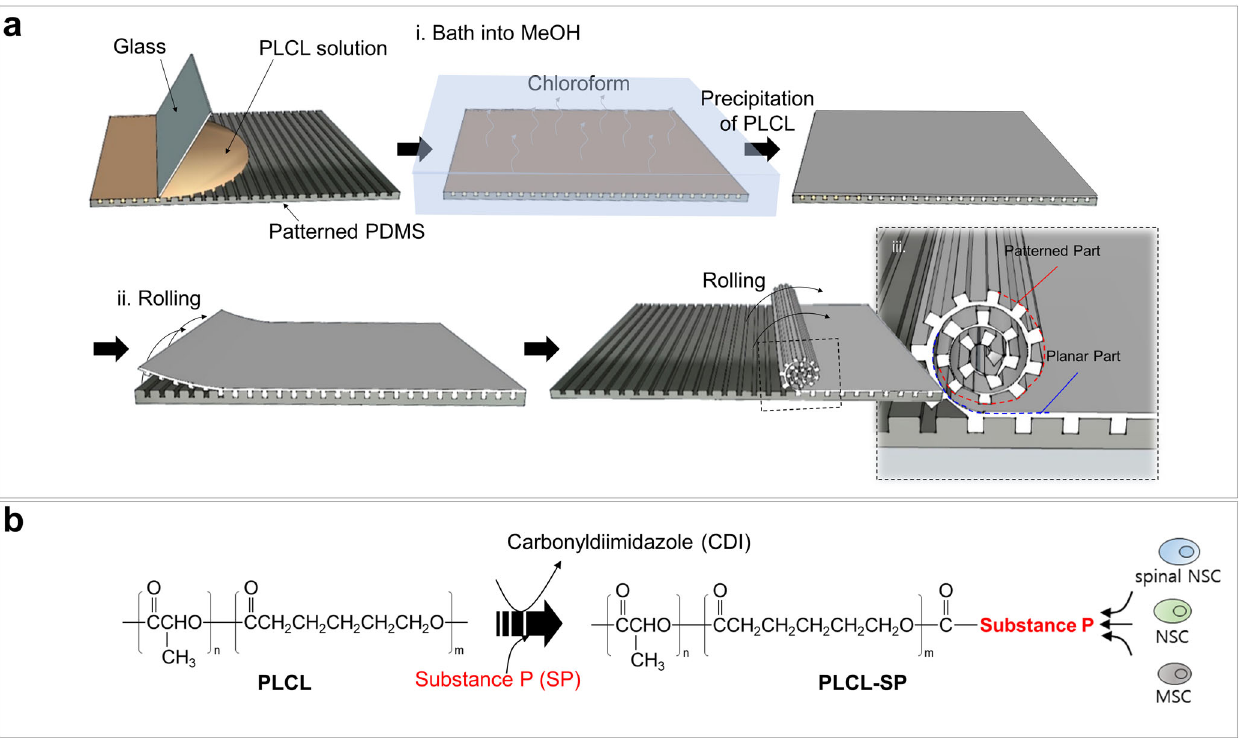
Fig. 1 Production of a multichannel NGC displaying stem-cell recruitment ability. a Schematic diagram of the micropattern-based multichannel NGC fabrication process. PLCL solution was cast on patterned PDMS with dimensions (ridge width × ridge height × groove width) of 10 μ m × 10 μ m × 20 μ m, 50 μ m × 30 μ m × 30 μ m, and 100 μ m × 50 μ m × 30 μ m, and spread using glass (i). The coated PLCL on the PDMS was bathed in methanol for precipitation from chloroform. PLCL holding on to the residual solvent acted as an adhesive, allowing the PLCL to roll. When the PLCL was rolled, the patterned part was attached to the planar part (ii). b Schematic diagram of SP immobilization on the PLCL molecules for stem-cell